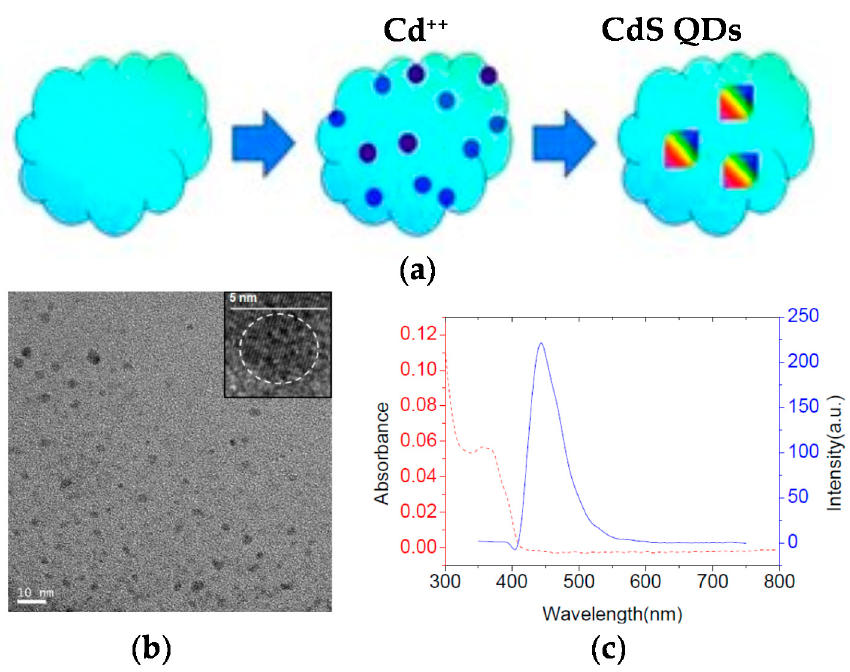
Figure 6. Schematic illustration of the generation of fluorescent CdS quantum dots (QDs) inside non-fluorescent SCNPs ( a ), transmission electron microscopy (TEM) image of the resulting CdS QDs showing an average size of 4.7 nm ( b ), and photoluminiscent emission spectrum (blue) of the CdS QDs displaying bright fluorescence centered at 450 nm ( c ) (reprinted from [43] with permission, Copyright Wiley-VCH, 2012).